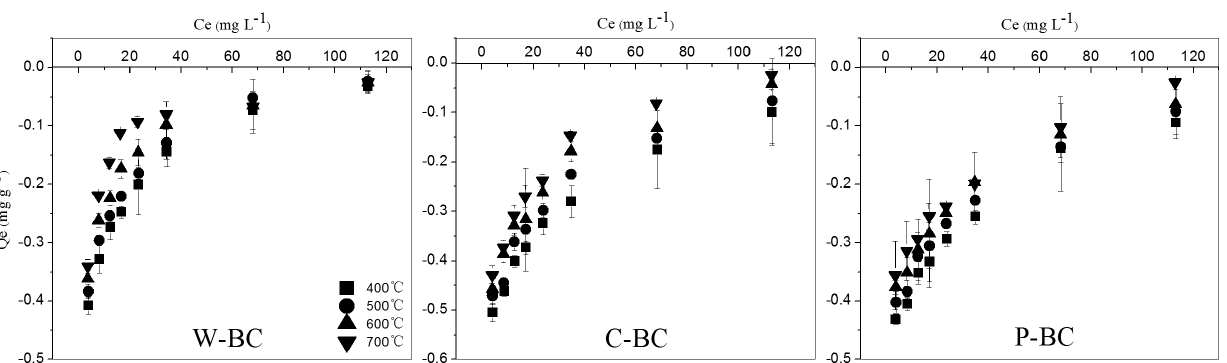
Figure 4. Sorption isotherms of NO 3 2 -N on wheat-straw biochar (W-BC), corn-straw biochar (C-BC) and peanut-shell biochar (P-BC) at different pyrolytic temperatures (Q e : the amount of NO 3 2 -N sorbed by per unit mass of biochar at equilibrium; Ce: concentration of NO 3 2 -N in the solution at equilibrium). Bars indicate standard deviation of three